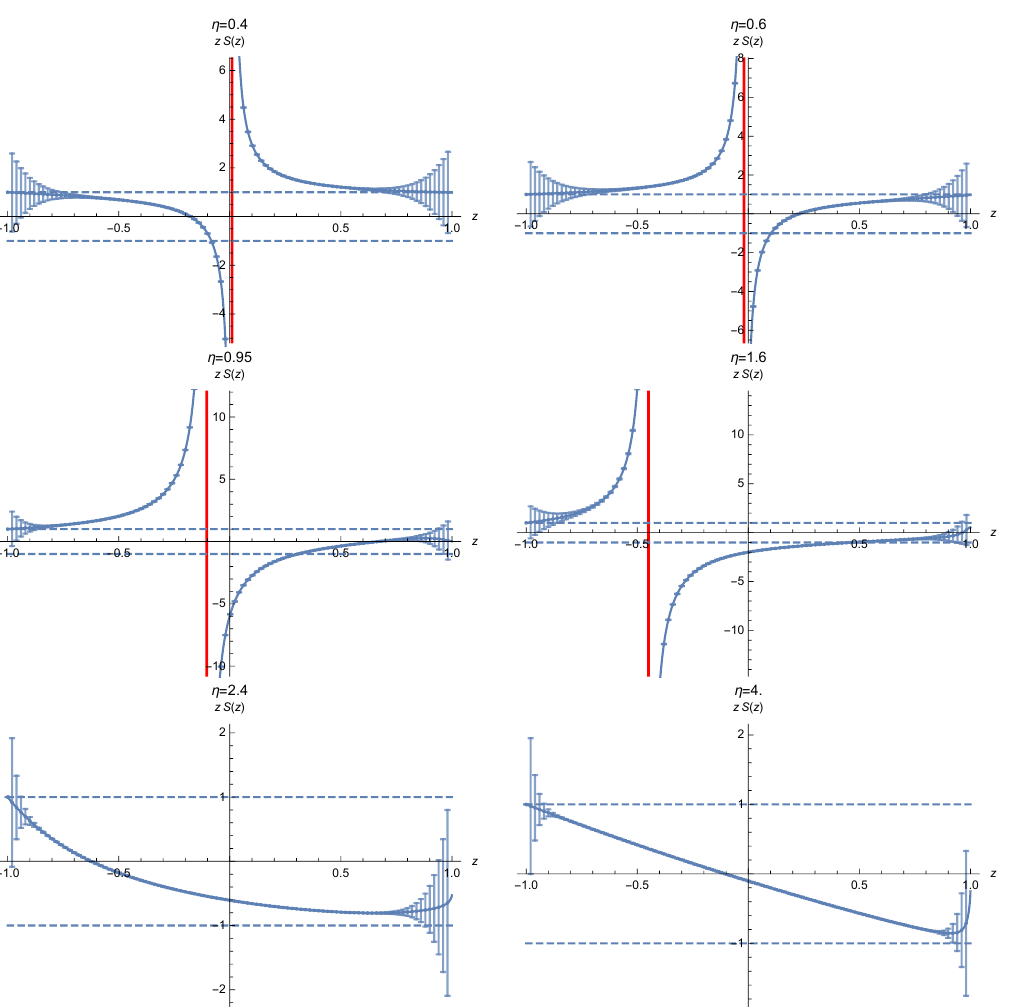
Figure 13. Numerical results for zS ( z ) and error bounds for real z ∈ ( − 1 , 1) at various η .